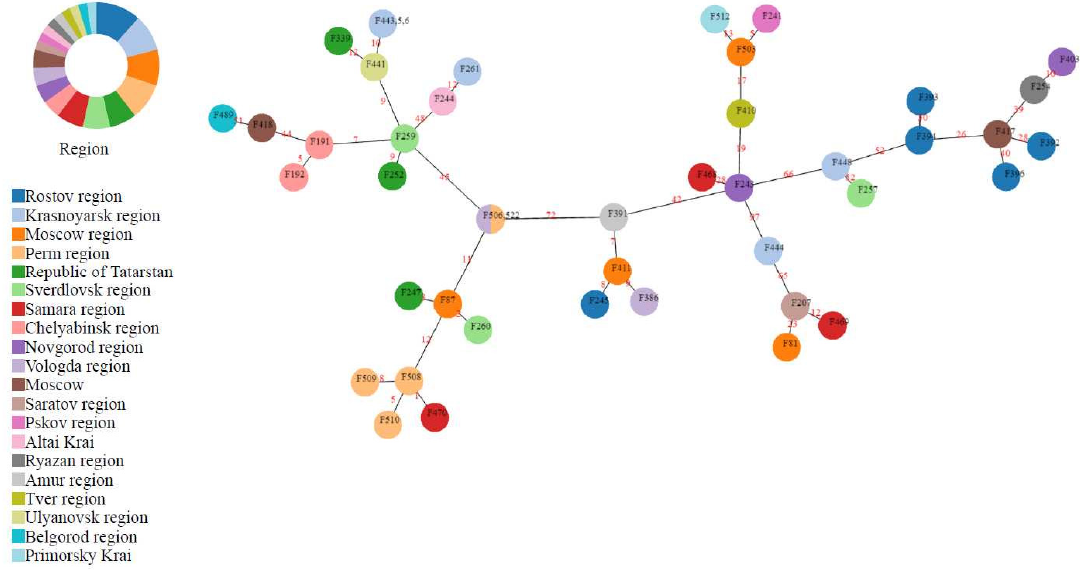
Figure 2. Minimum spanning tree (MST) based on cgMLST profiles for ST32 S . Infantis isolates. The number of different alleles between the profiles is shown on the branches connecting the respective isolates. The node CrieF443 had a completely identical profile to Crie-F445 and Crie-F446, thus they are combined in one node, as well as Crie-F522, whose profile was the same as for Crie-F506. Nodes are colored by the region of isolate